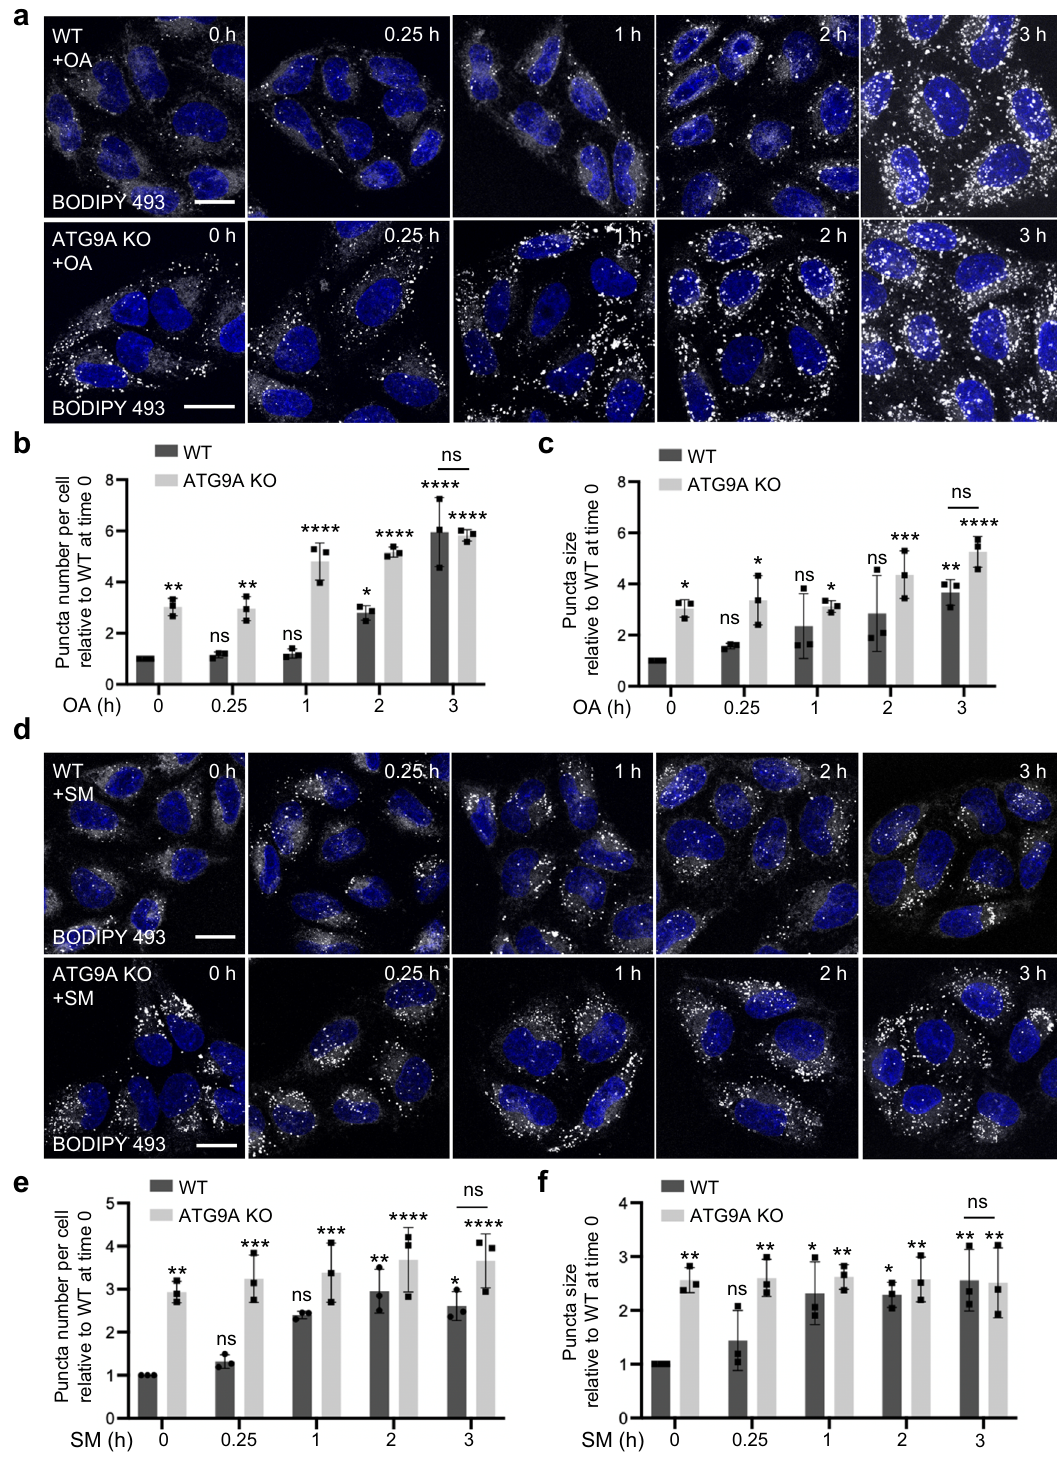
Fig. 3 ATG9A KO phenocopies LD alterations caused by OA feeding or starvation. a Effect of OA treatment on LDs in WT and ATG9A-KO cells. Cells were incubated for the indicated times at 37 o C with 200 μ M oleic acid (OA), fi xed, permeabilized, stained for LDs with BODIPY 493 (green) (shown in grayscale) and nuclei with DAPI (blue), and examined by confocal fl uorescence microscopy. Scale bars: 10 μ m. Results are representative from three independent experiments. b , c The number per cell ( b ) and size ( c ) of LDs were quanti fi ed in 20 cells in each of three independent experiments using the “ Analyze particles ” function of Image J. Bar graphs represent the mean ± SD fold-change of these values relative to WT cells at time 0. Statistical signi fi cance was determined using one-way ANOVA with Tukey post-hoc test (ns p > 0.05, * p < 0.05, ** p < 0.01, *** p < 0.001, **** p < 0.0001). d Effect of starvation on LDs in WT and ATG9A-KO cells. Cells were incubated for the indicated times in amino-acid- and serum-free medium (starvation medium or SM), and analyzed by confocal fl uorescence microscopy as described for panel a . Scale bars: 10 μ m. Results are representative from three independent experiments. e , f The number per cell ( e ) and size ( f ) of LDs were quanti fi ed as described for panels b , c . NATURE COMMUNICATIONS| (2021) 12:6750